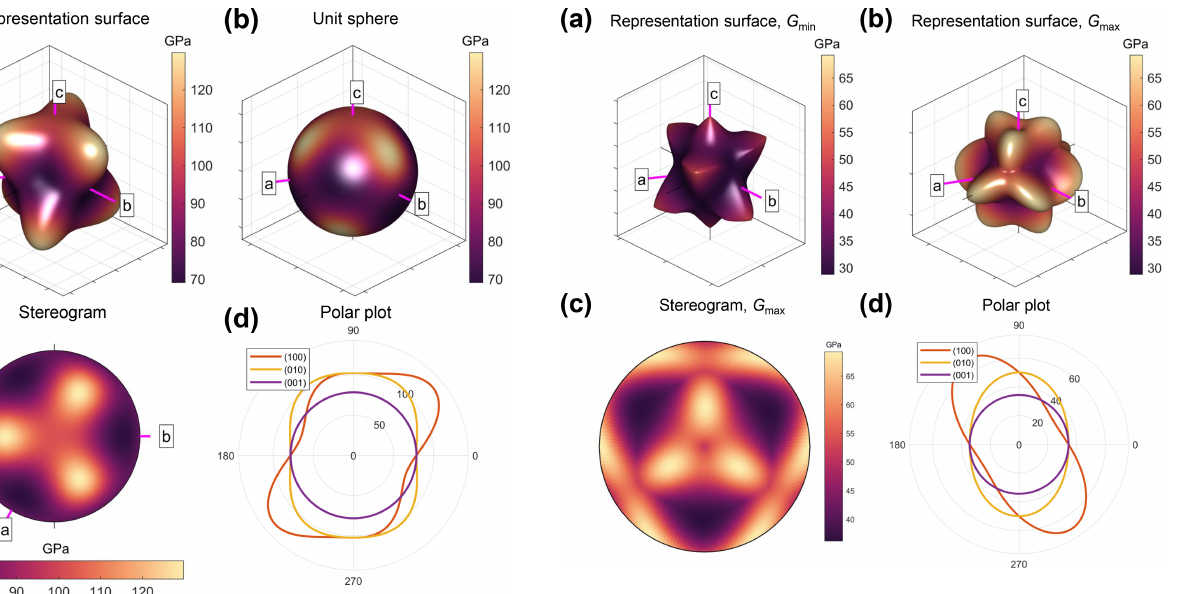
Figure 5. Alternative visualisations of the anisotropy of shear mod- ulus ( G , in GPa) of α -quartz. (a–b) 3D representation surfaces where the radius in any direction is proportional to the magni- tude of G . Separate surfaces shown for minimum and maximum G . (c) Lower-hemisphere equal-area stereographic projection of G max . (d) Polar plots of anisotropy of G in selected planes. Crystallo- graphic axes (cid:104) a (cid:105) , (cid:104) b (cid:105) and (cid:104) c (cid:105) shown in pink. VRH represents the Voigt–Reuss–Hill average value of G